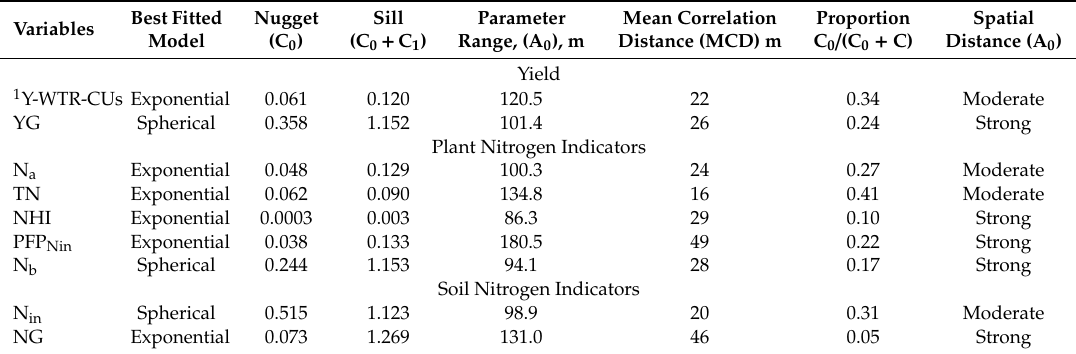
Table 9. Semivariogram parameters of yield and selected plant and soil nitrogen indicators—WTR.